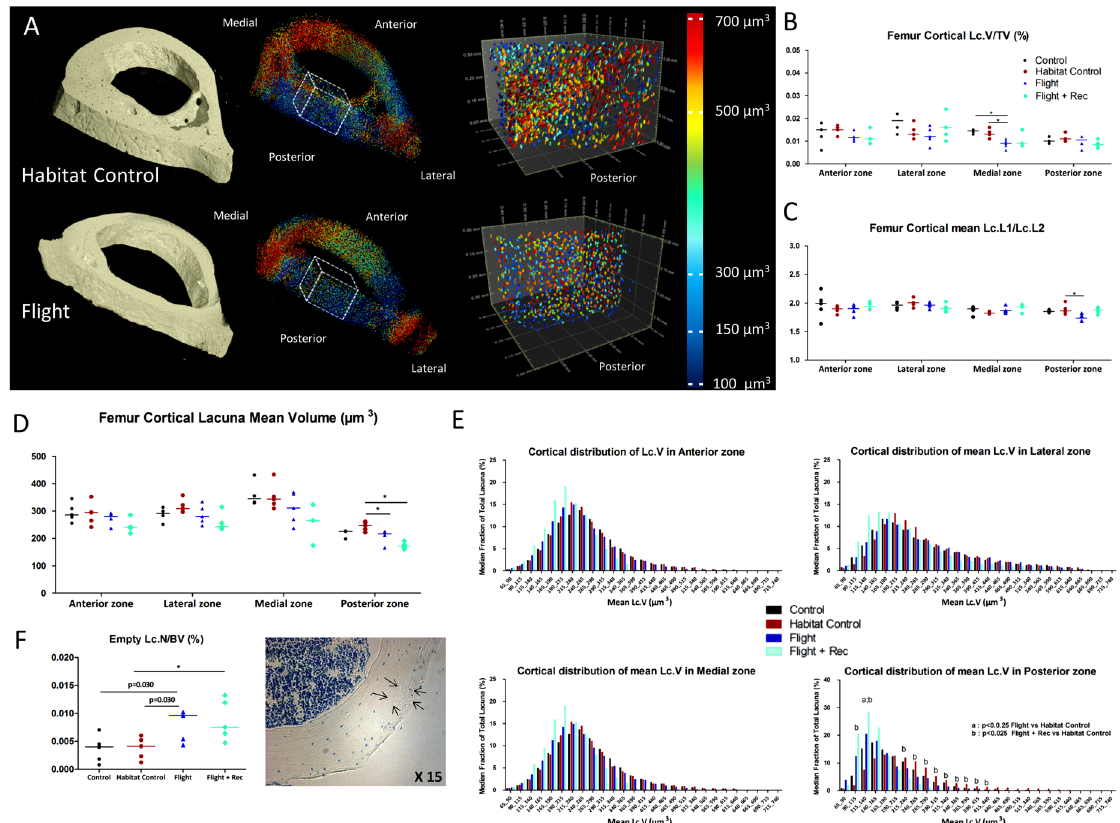
Figure 7. Effects of spacecraft housing conditions, spaceflight and recovery on osteocyte lacunae volume and shape. ( A ) A 3D colour map reconstruction of synchrotron radiation imaging showing total bone, total lacunae, and magnification of posterior zones in one Flight and Habitat Control mouse. ( B , C ) Lacunae total volume and shape (Lc.L1/Lc.L2), ( D , E ) lacunae mean volume and distribution, and ( F ) empty lacunae fraction measured by histomorphometry. Data are presented as clusters of individual points (bars = median). p < 0.017, ** p <